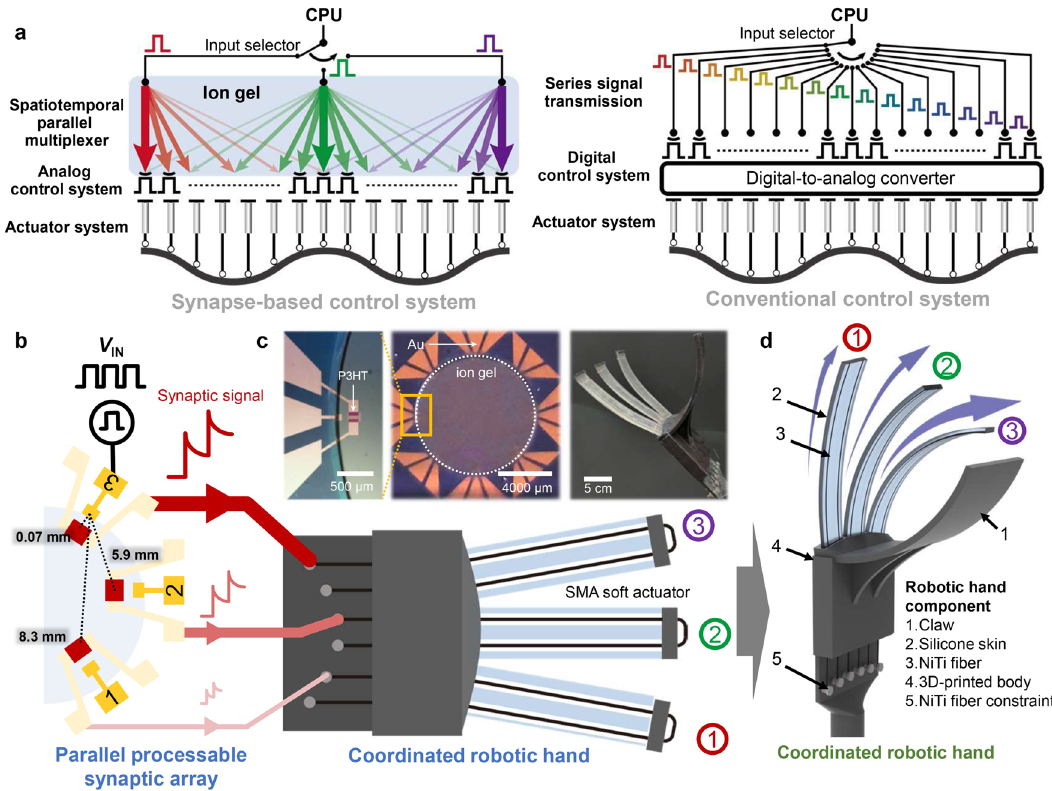
Fig. 1 | Parallel processable robotic control system capable ofion-based signal multiplexing. a Schematic comparison between a synapse-based control system and a conventionalcontrol system. b Schematic of CRH control through the PPSA.